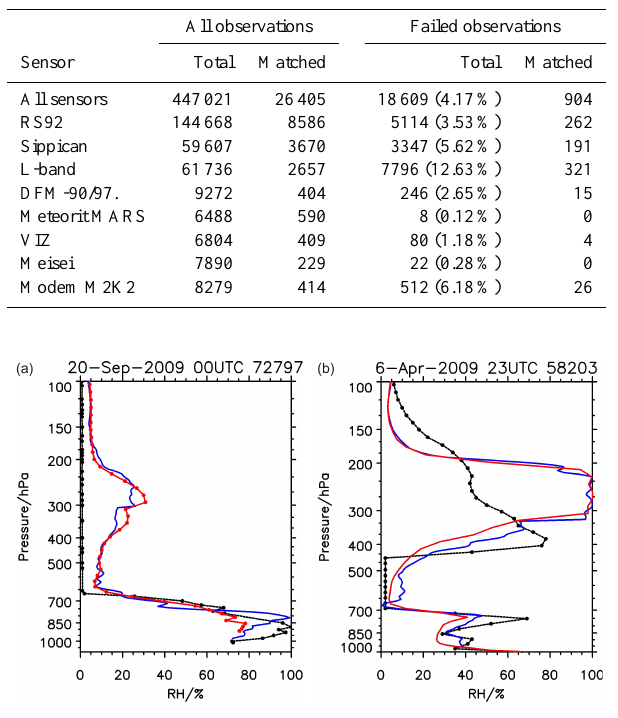
Figure 6. Comparison of the relative humidity profiles among the radiosonde (black), COSMIC retrieval (blue) and ECMWF reanal- ysis (red). Panel (a) represents the observations of the Quiliayute station (72797, USA) at 00:00:00UTC, 20 September 2009, and (b) represents the observations of Fuyang station (58203, China) at 23:16:41UTC, 6 April